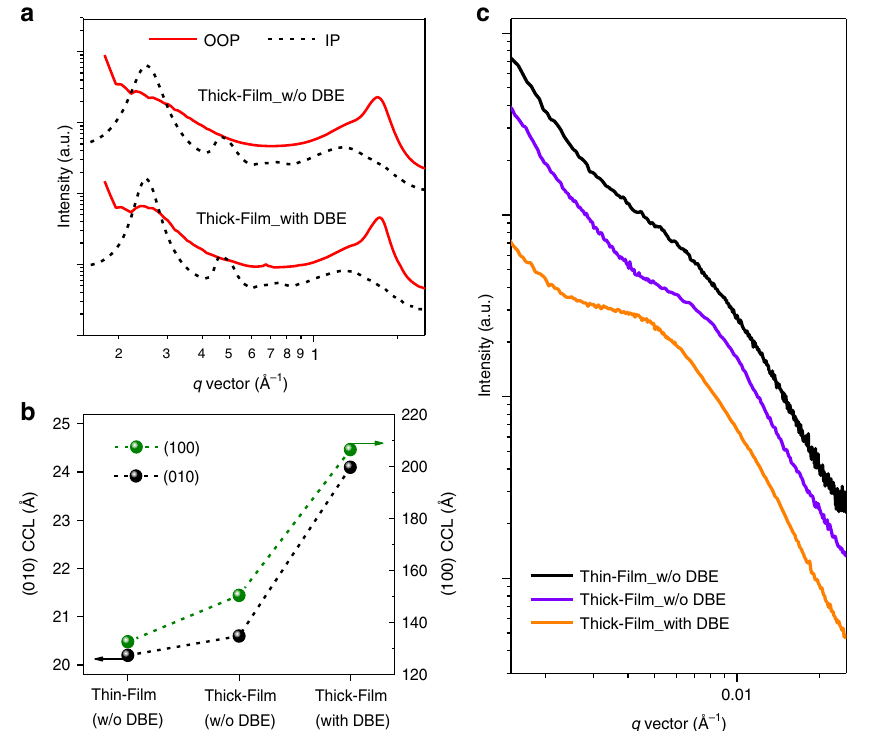
Fig. 3 Morphology for PBTA-Si:PTzBI-Si:N2200 (1.3:0.7:1) blend fi lms. a GIWAXS line-cuts for thick fi lms without DBE and with 0.1 vol% DBE (OOP: out- of-plane; IP: in-plane). b Crystal coherence length (CCL) for the (010) and (100) scattering peaks. c RSoXS circular averaged pro fi les for various 1.3:0.7:1- blend fi